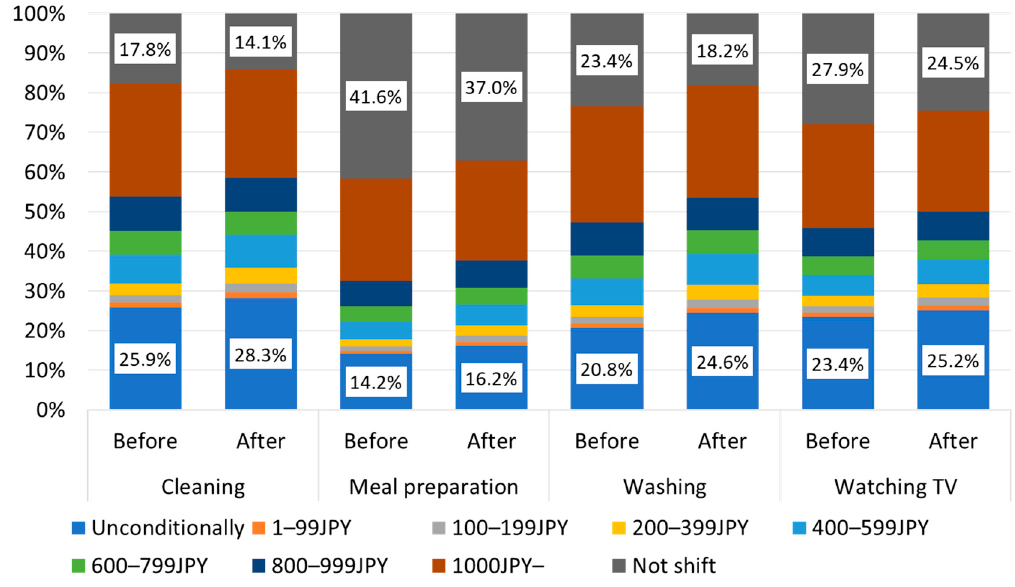
Figure 3. Changes in activity time shift intention before and after providing knowledge (all